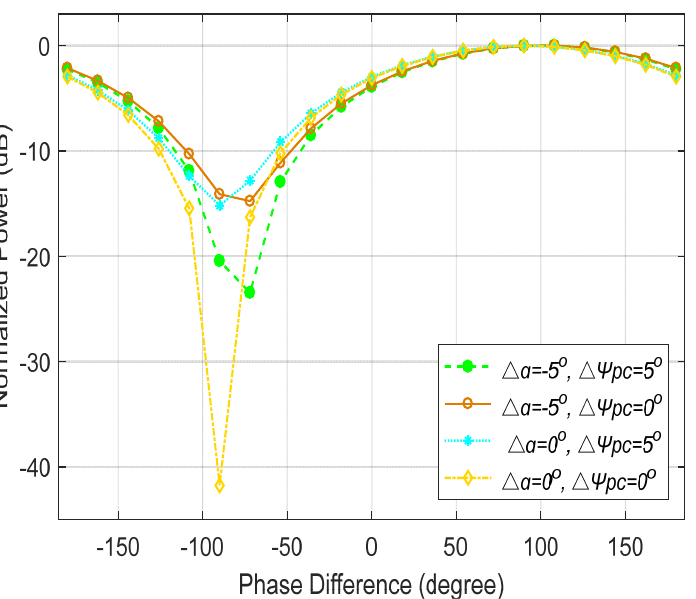
Figure 7. The influence of the polarization angle α and the phase shift ψ PC introduced by PC on normalized power of the output signals.